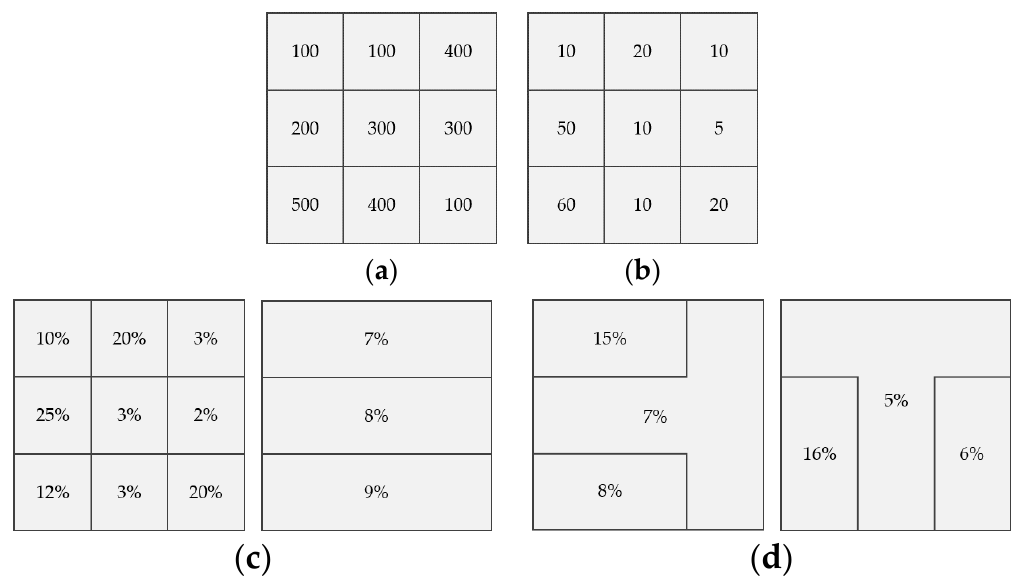
Figure 1. Example of the MAUP scale effect and zoning effect: ( a ) base population; ( b ) unemployed count; ( c ) scale effect; and ( d ) zoning effect [20].